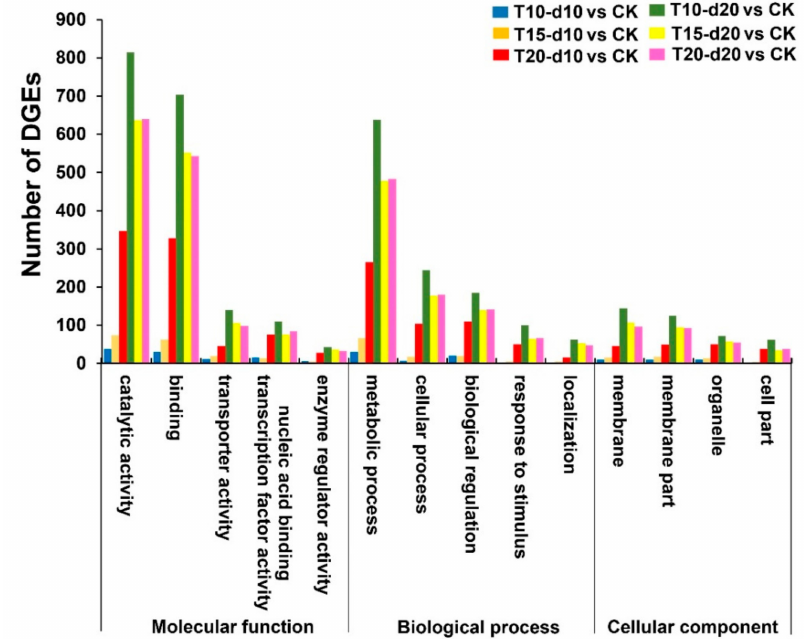
Figure 3. Gene Ontology analysis of DEGs in di ff erent treatments. DEGs were annotated in three main categories: biological process, cellular component, and molecular